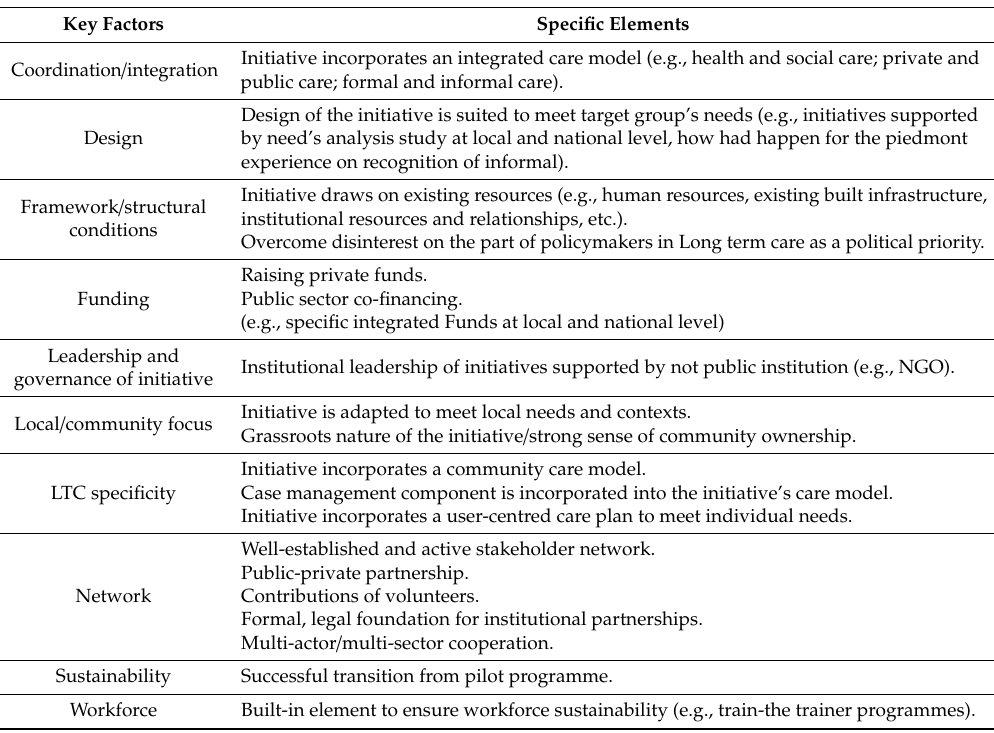
Table 4. SI Key factors in Italian LTC and specific